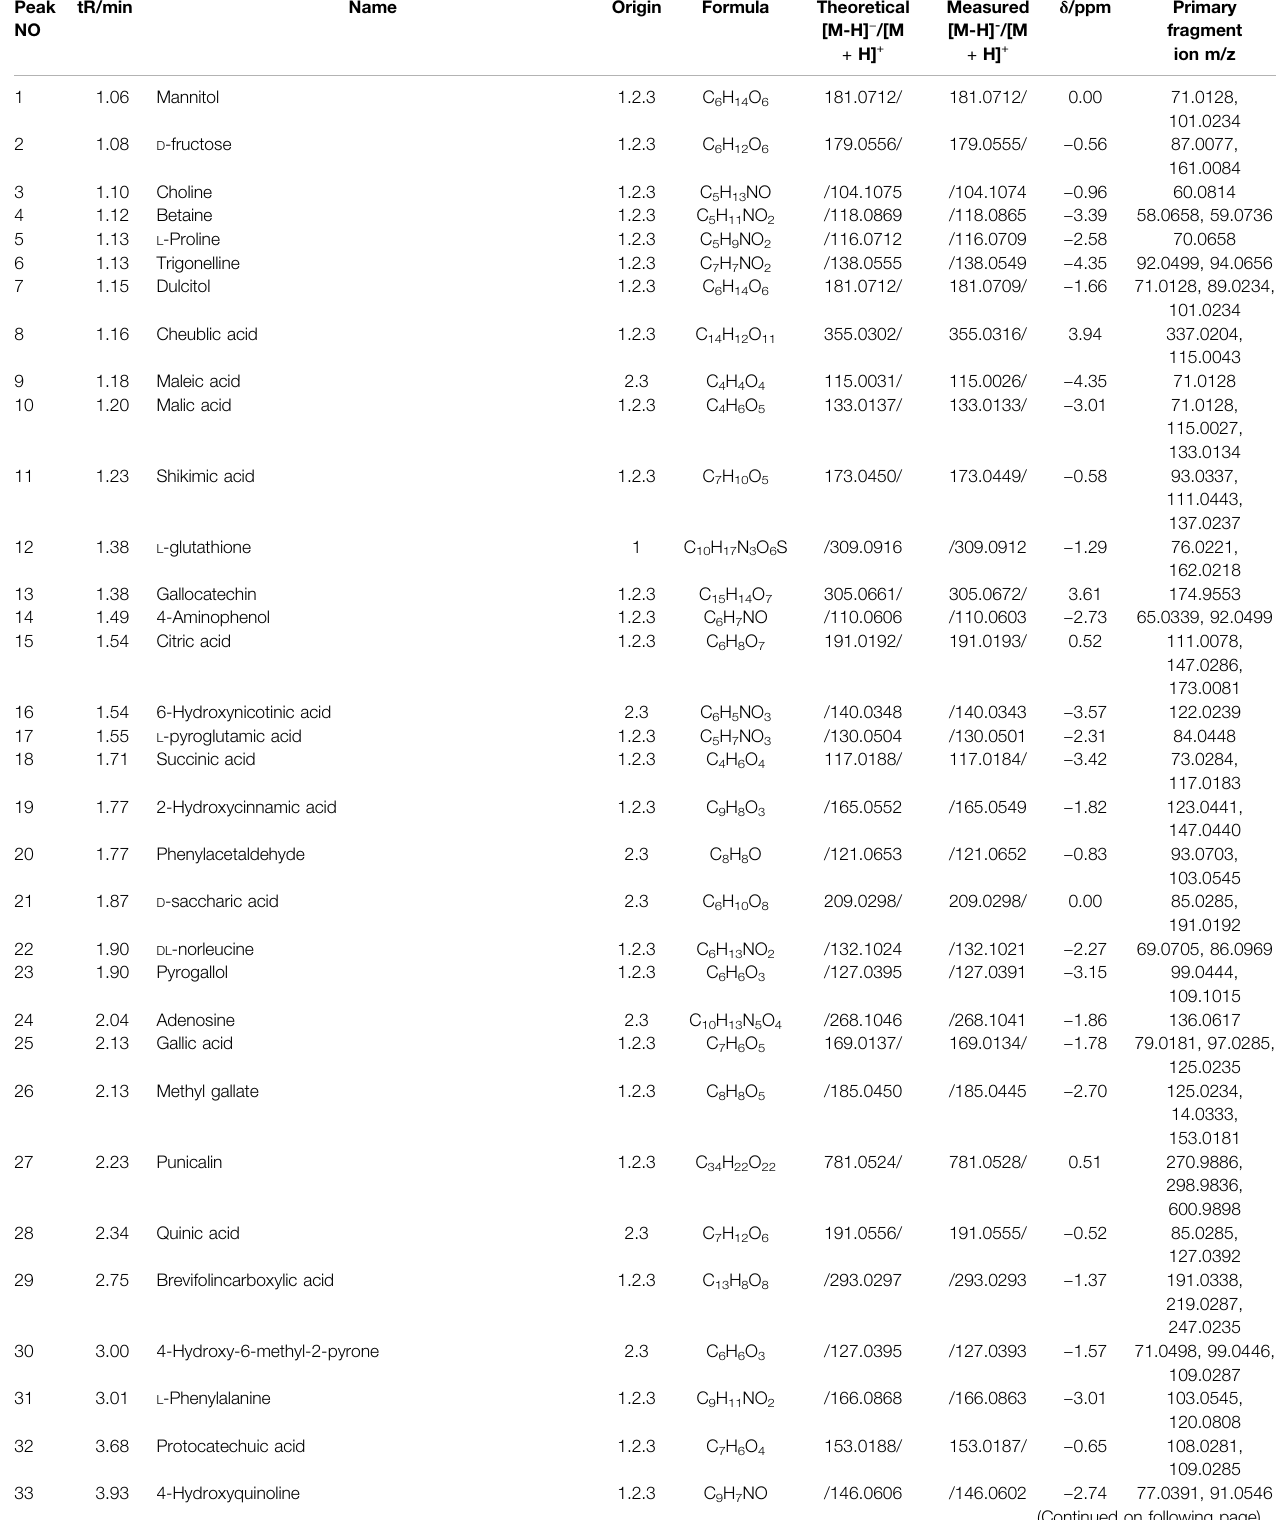
TABLE 4 | UPLC-Q-Orbitrap HRMS identi fi cation results. Peak